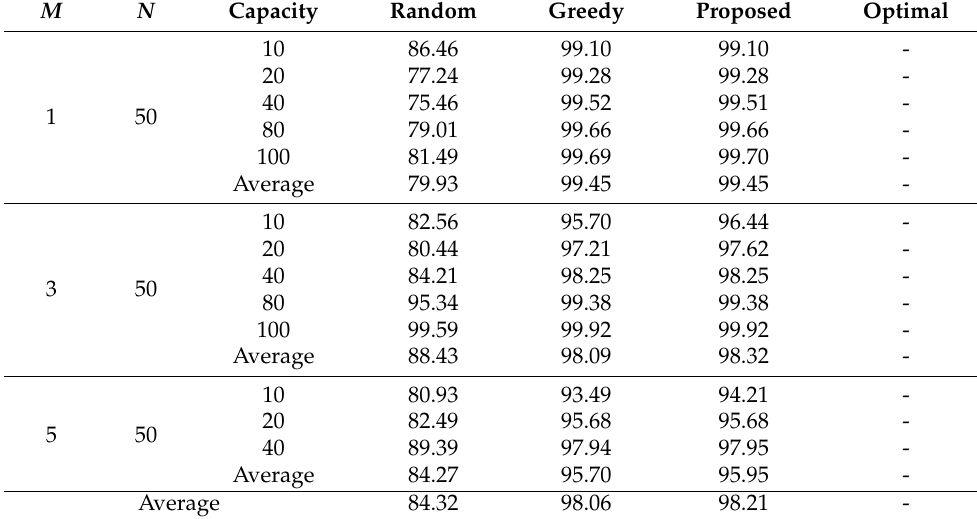
Table 4. The closeness to the optimal solution in RI set.